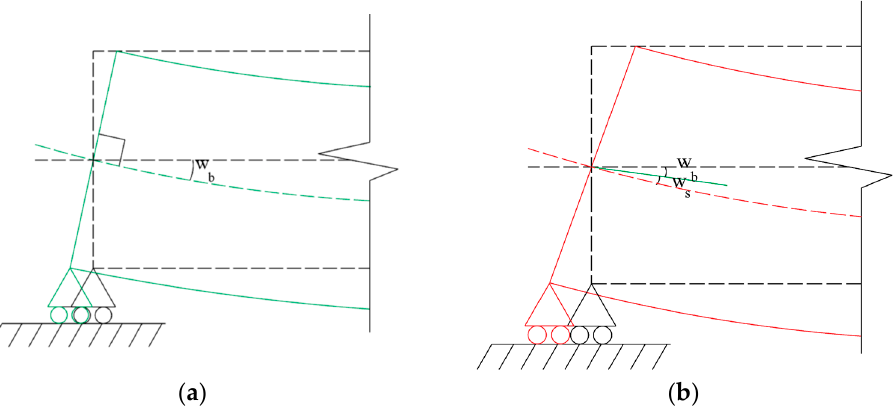
Figure 1. Support rotation of a beam support according to Euler–Bernoulli’s ( a ) and Timoshenko’s beam theories ( b ).